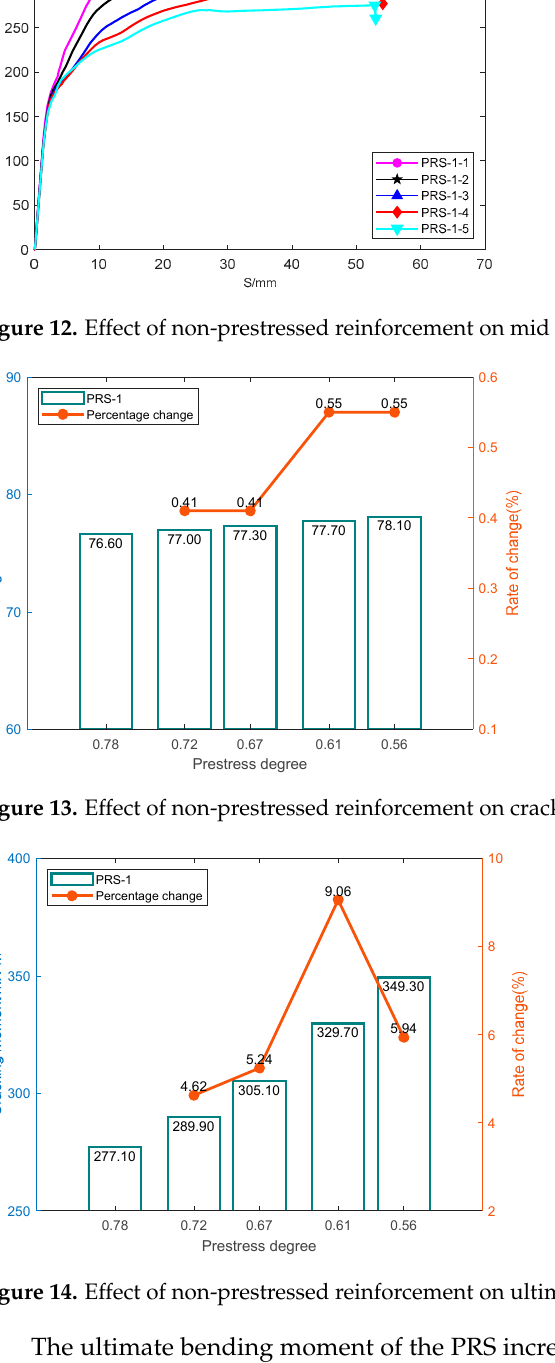
Figure 14. Effect of non-prestressed reinforcement on ultimate bending moment. The ultimate bending moment of the PRS increased continuously with the increase of the non-prestressed reinforcement ratio. Its increase shows a process of increasing and then decreasing with the increase of the non-prestressed reinforcement ratio. There is an optimal non-prestressed reinforcement ratio. For the PRS with the 0.27% prestressed steel strand, the prestressed degree is 0.61 at 0.64%, and a non-prestressed reinforcement ratio has the best performance. It means the model PRS-1-2 has the best bending